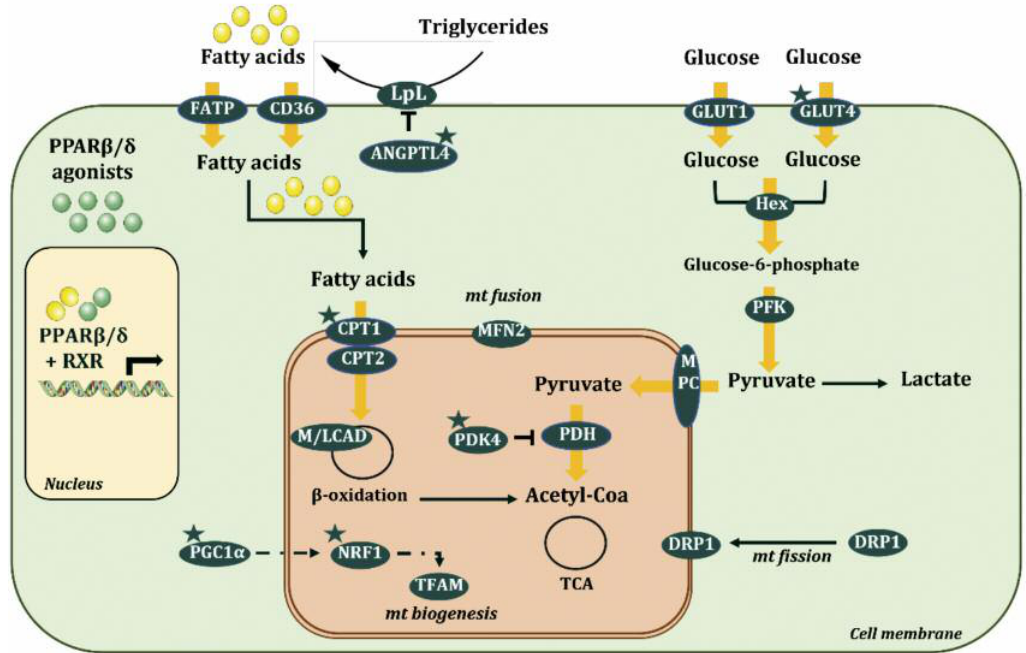
Figure 3. PPAR β / δ regulates multiple aspects of energy metabolism and mitochondrial quality control. PPAR β / δ enhances glucose uptake into cardiac myocytes through GLUT4 activation, while activating PDK4 transcription, thus suppressing the influx of acetyl- CoA from glycolysis into the TCA cycle. Simultaneously, PPAR β / δ upregulates ANGPTL4, an inhibitor of LpL, which is responsible for hydrolyzing triglycerides into free fatty acids, stimulates CPT1-mediated delivery of fatty acids to the mitochondrial matrix and increases β -oxidation rates to increase the influx of acetyl-CoA into the TCA cycle. By controlling PGC1 α , the master regulator of mi- tochondrial biogenesis, and NRF1, PPAR β / δ is a critical mediator of mitochondrial homeostasis and it has also been implicated in the regulation of mitochondrial fission and fusion. Stars denote direct transcriptional targets of PPAR β / δ ; arrows with dashes denote transcriptional